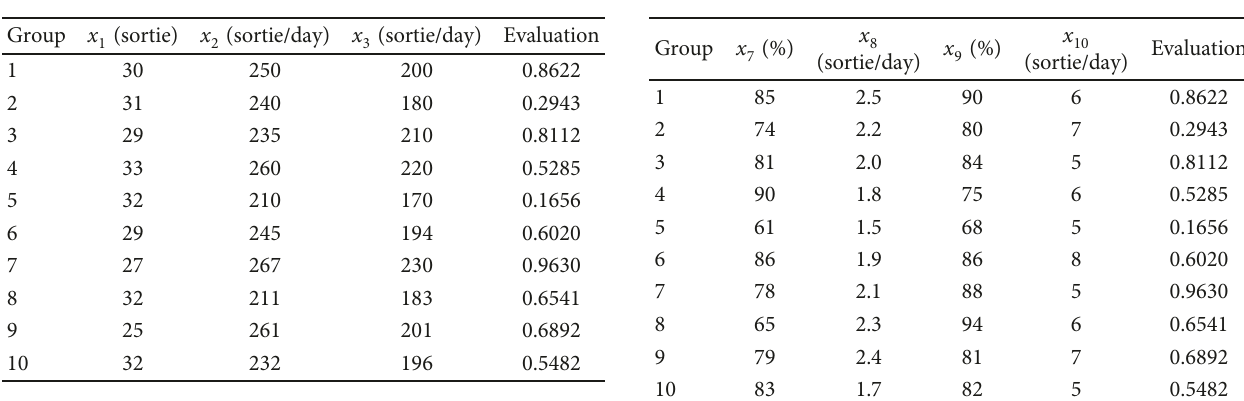
Table 5: Task completion capacity.